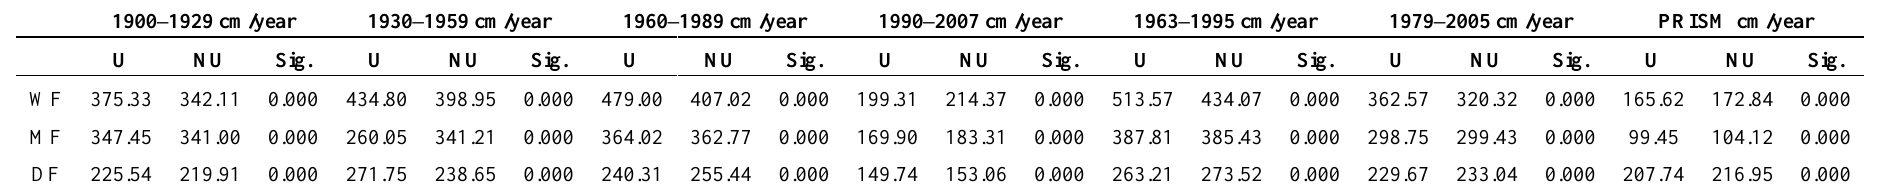
Table 9. Yearly average total precipitation for each period and its corresponding urban vs. non urban T-test significance values: 100 m grid